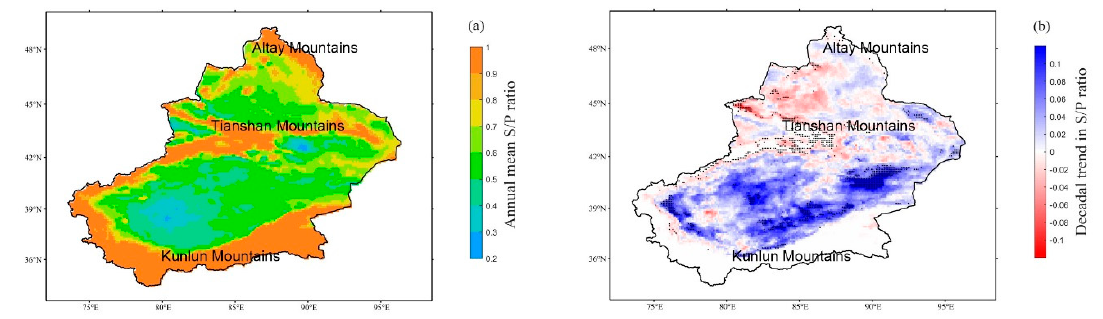
Figure 4. Spatial distribution of climatology ( a ) and variation ( b ) of the S/P ratio in Xinjiang revealed by WRF from 1979 to 2015. Black dots represent significance at the 0.05 level.